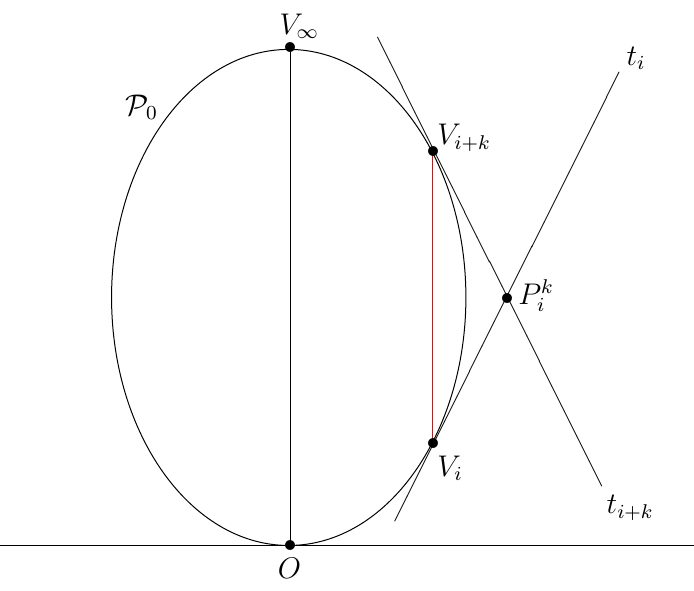
Figure 1: Representation of the edge V